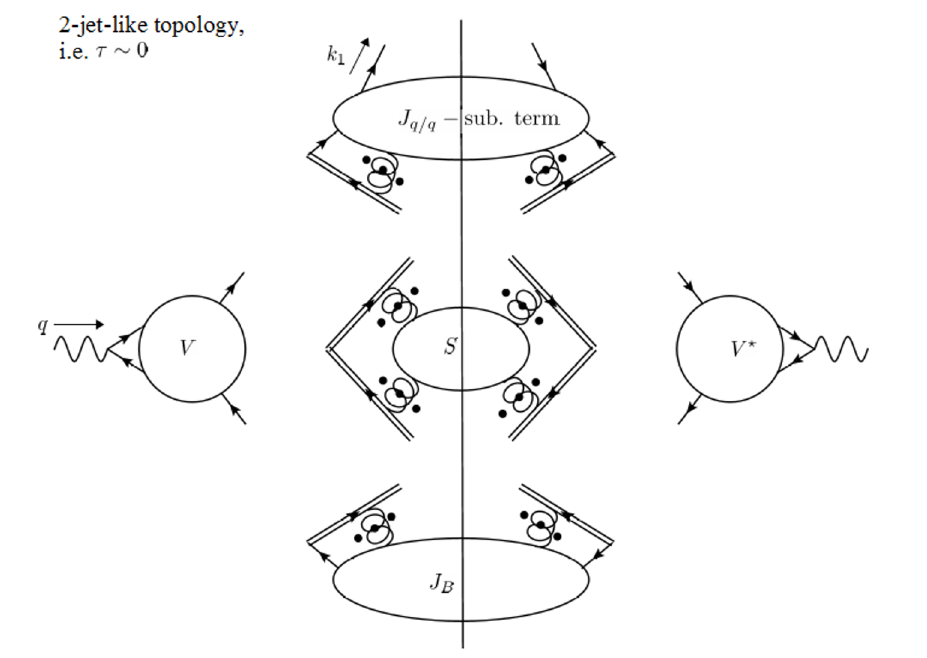
in a 2 -jet-like topology. Every blob j